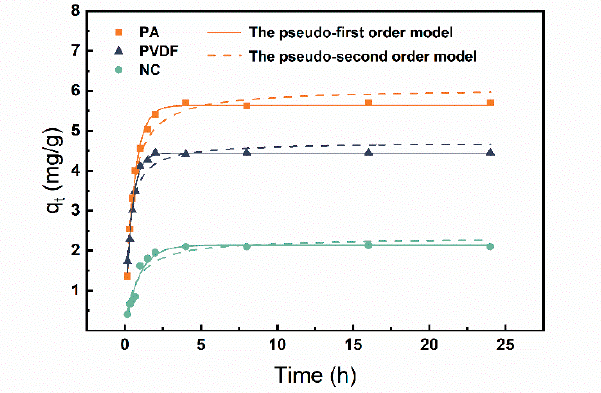
Figure 2. The kinetic adsorption model fitting of the pseudo-first-order model and pseudo-second- order model for the adsorption of BPA onto three MFMs. Table 2. The kinetic adsorption constants of BPA by three MFMs.